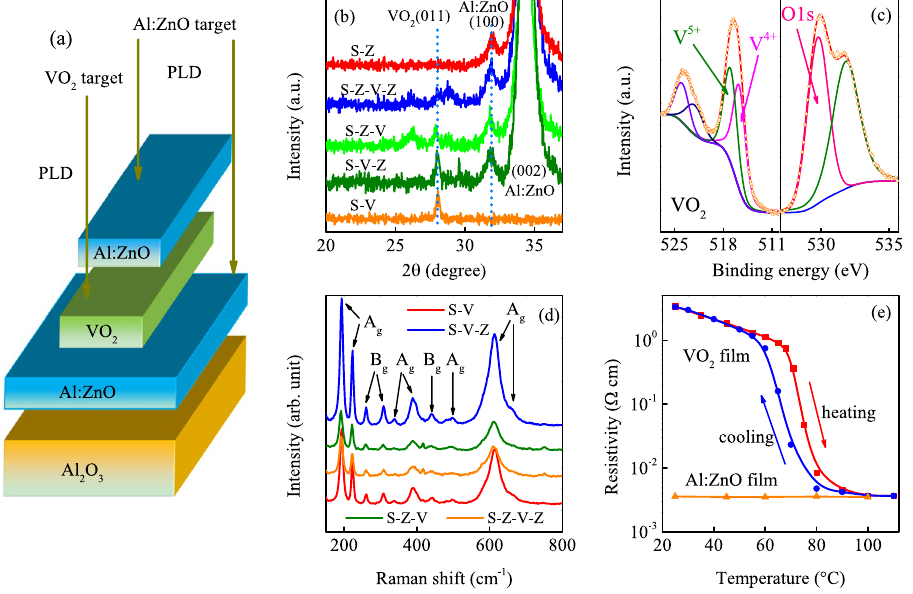
Figure 1. ( a ) The detailed structure of the hybrid S-Z-V-Z heterojunction. ( b , c ) The XRD curves of the five structures and the XPS spectra of pure VO 2 film, respectively. ( d ) The Raman spectra of the hybrid structures ( e ) The resistivity of the VO 2 and Al:ZnO film with temperature,